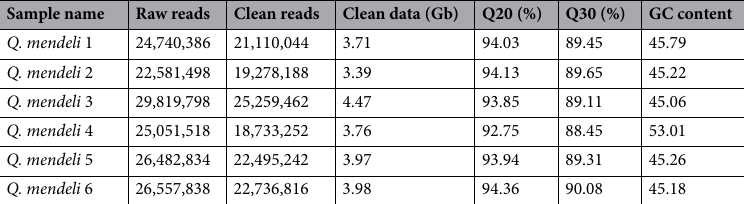
Table 1. Sequencing summary of the Quadrastichus mendeli transcriptome.